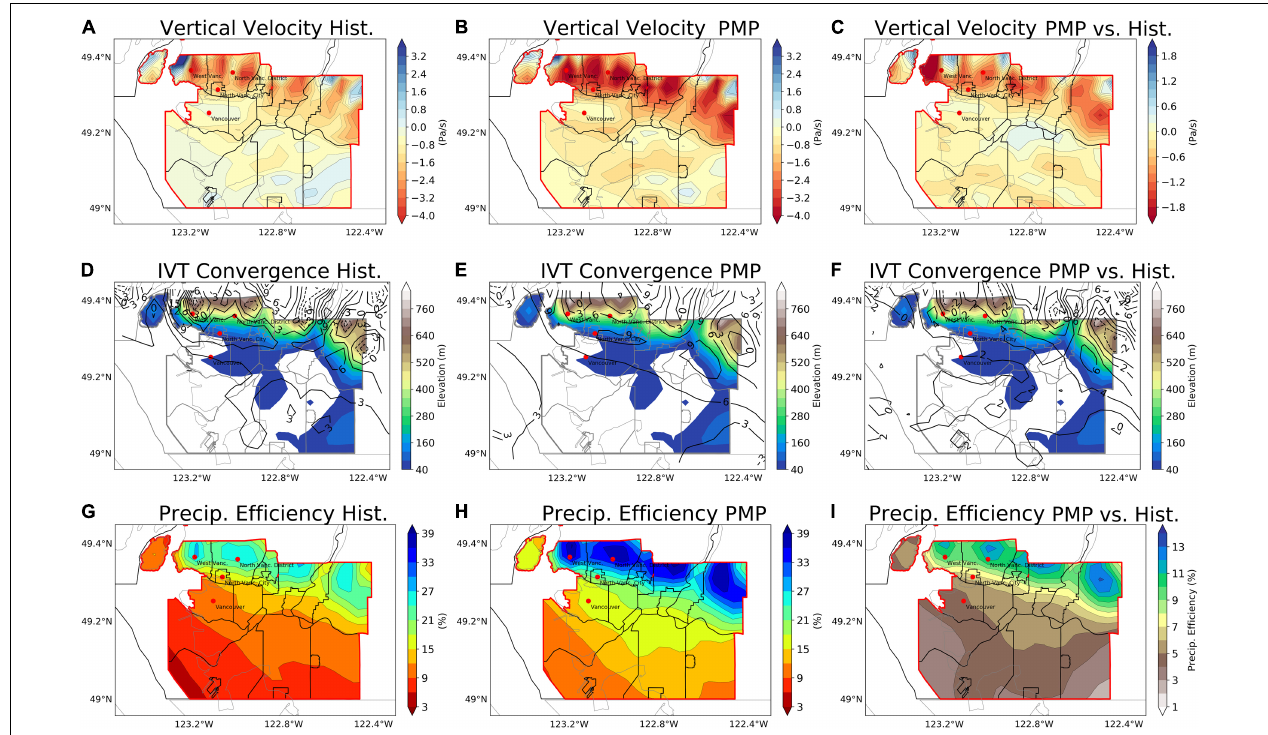
FIGURE 9 | Dynamical environmental fields when the maximum 72-h precipitation occurred for the simulated historical extreme precipitation events, including the pressure-weighted vertically averaged vertical velocity between 850 and 1000-hPa (A–C) , IVT convergence (black contours, unit: mm/h) and elevation (D–F) and precipitation efficiency (G–I) : (A,D,G) the historical events; (B,E,H) PMP; (C,F,I) the absolute changes for PMP relative to the historical